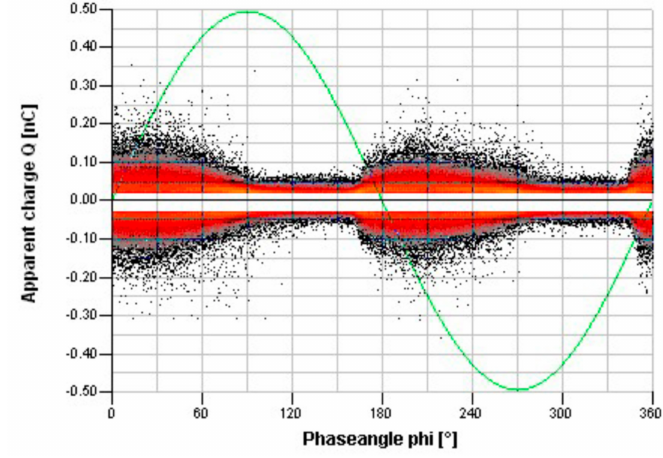
Figure 7. PD activity in Phase U